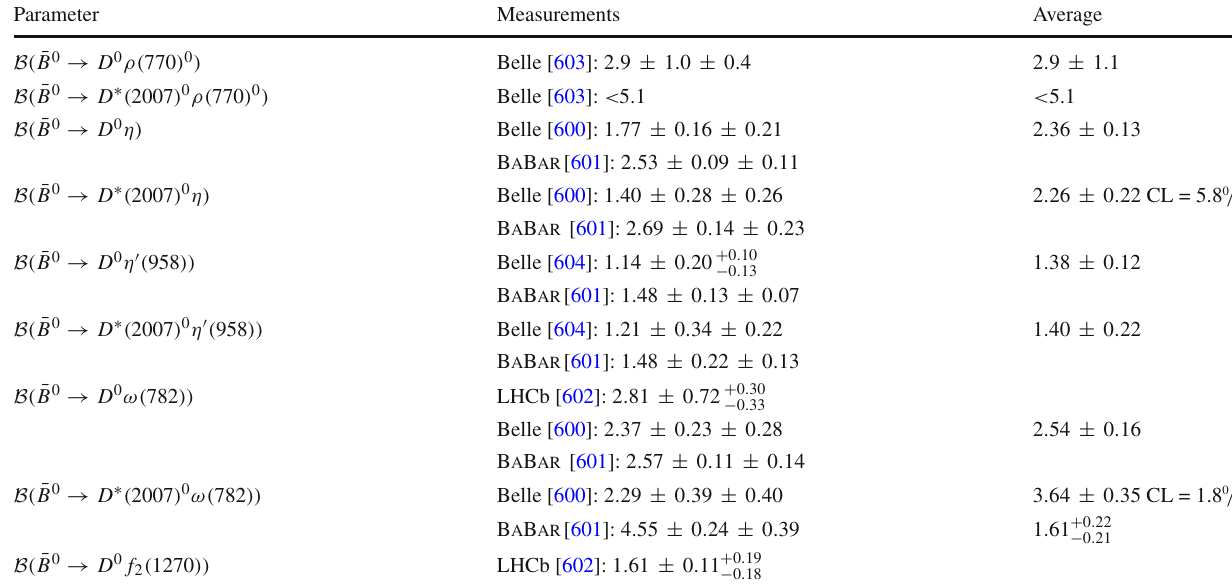
Table 95 Decays to a D ( ∗ ) 0 meson and a light meson [ 10 − 4 ] Parameter Measurements